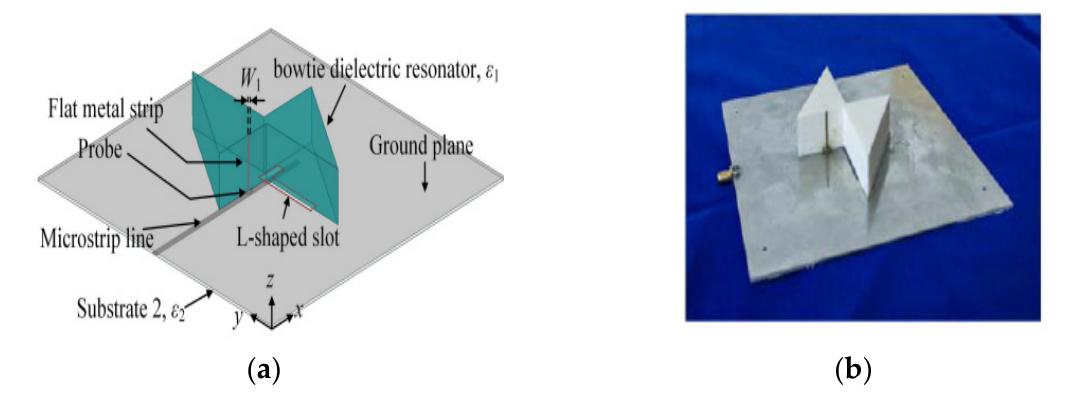
Figure 11. Proposed bowtie DRA: ( a ) 3D view; ( b ) fabricated DRA [28].